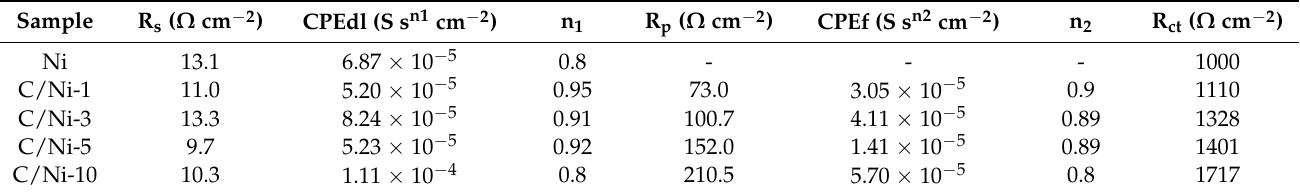
Figure 6. ( a ) EIS plots and fitted curves; Equivalent circuit of ( b ) bare Ni and ( c ) the coated Ni samples. Table 2. Values of fitted elements in equivalent circuits.